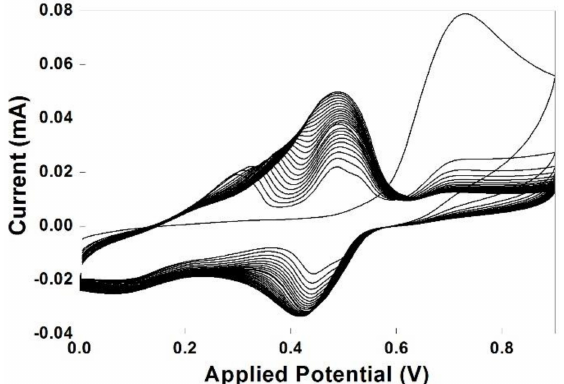
Figure 1. Electropolymerization of 10 mM 1,5-daminonaphthalene in 0.25 M H 2 SO 4 at a scan rate of 50 mVs − 1 over 25 cycles. The electropolymerization was carried at room